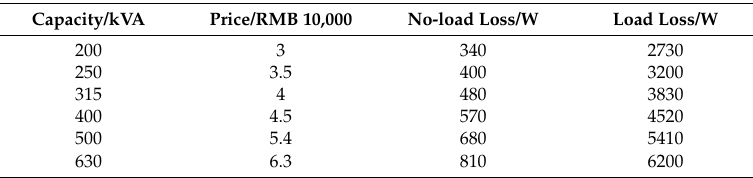
Table 3. Parameters for conventional distribution